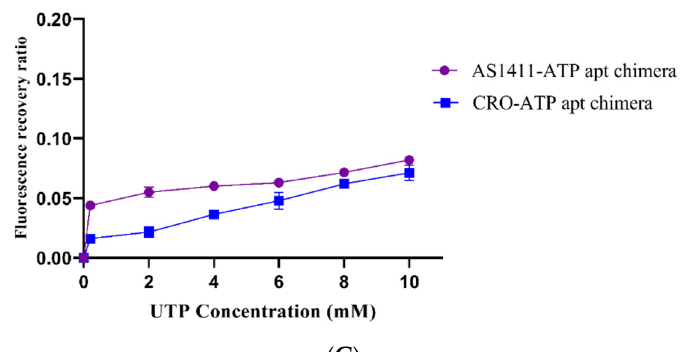
Figure 4. ATP-triggered doxorubicin release from the aptamer–aptamer chimera. ( A ) Fluorescence recovery ratios of aptamer–aptamer Dox loaded in the presence of different concentrations of ATP. Error bars indicate SD ( n = 3). ( B ) Fluorescence recovery ratios of doxorubicin-loaded chimeras in the presence of 4 mM ATP and 0.4 ATP. Error bars indicate SD ( n = 3). ( C ) Fluorescence recovery ratios of doxorubicin-loaded chimeras in the presence of different concentrations of UTP. Error bars indicate SD ( n = 3).